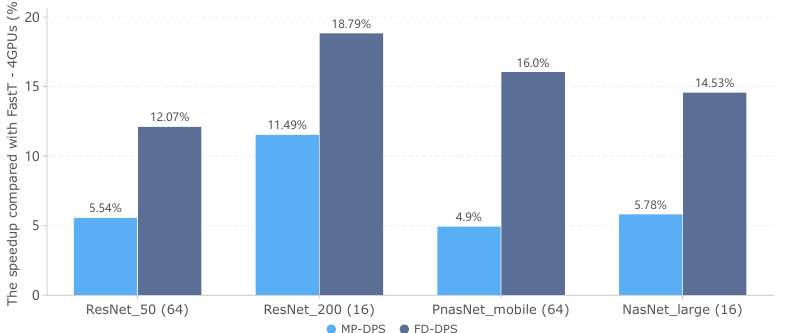
Figure 4. Single-round iteration time speedup comparison (two dockers with eight GPUs).